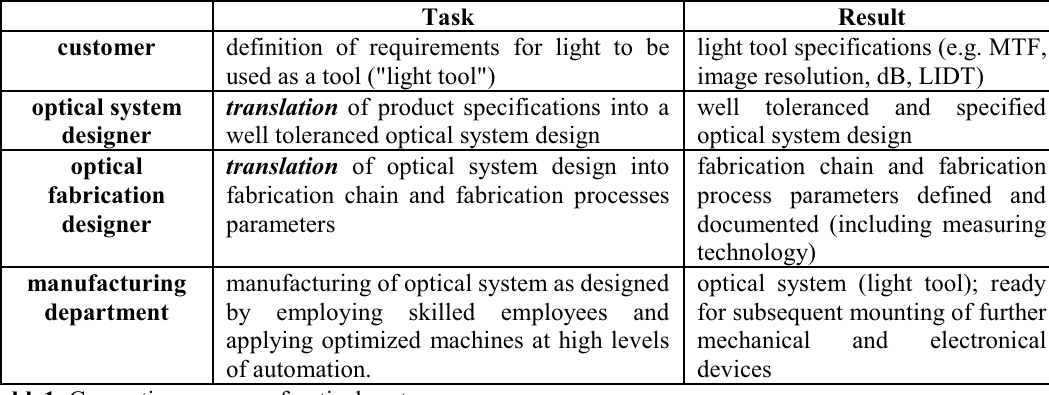
Table1. Generation process of optical systems